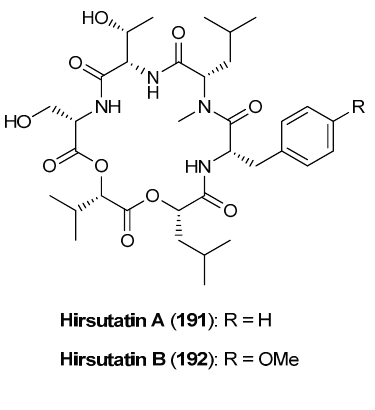
Figure 20. Structure of hirsutatin A ( 191 ) and B ( 192